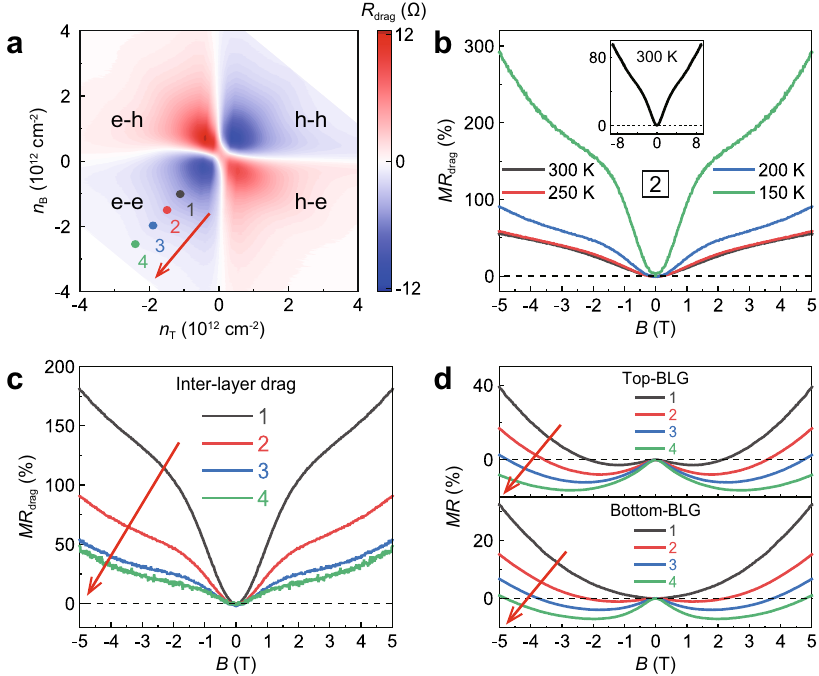
Fig. 2 | Evolution of magneto-drag behaviors with varying temperatures and carrier densities. a R drag vs. ( n T , n B ) at T =200K, which is extracted from the data shown in Fig. 1d. b Magneto-drag resistance ( MR drag ) curves measured at different temperatures for point “ 2 ” indicated in ( a ) (the same as point “ I ” indicated in